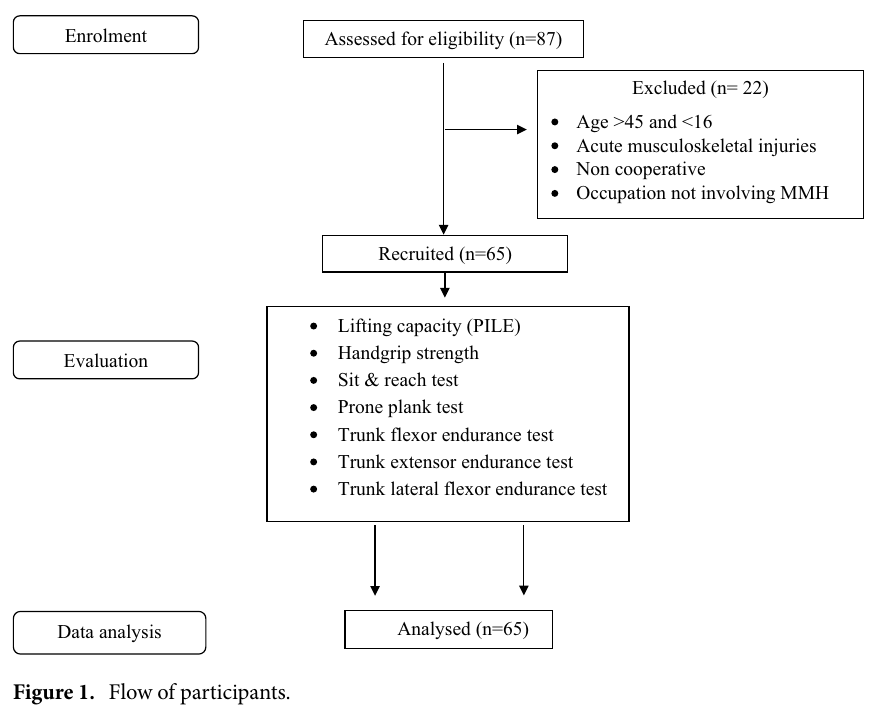
Figure 1. Flow of